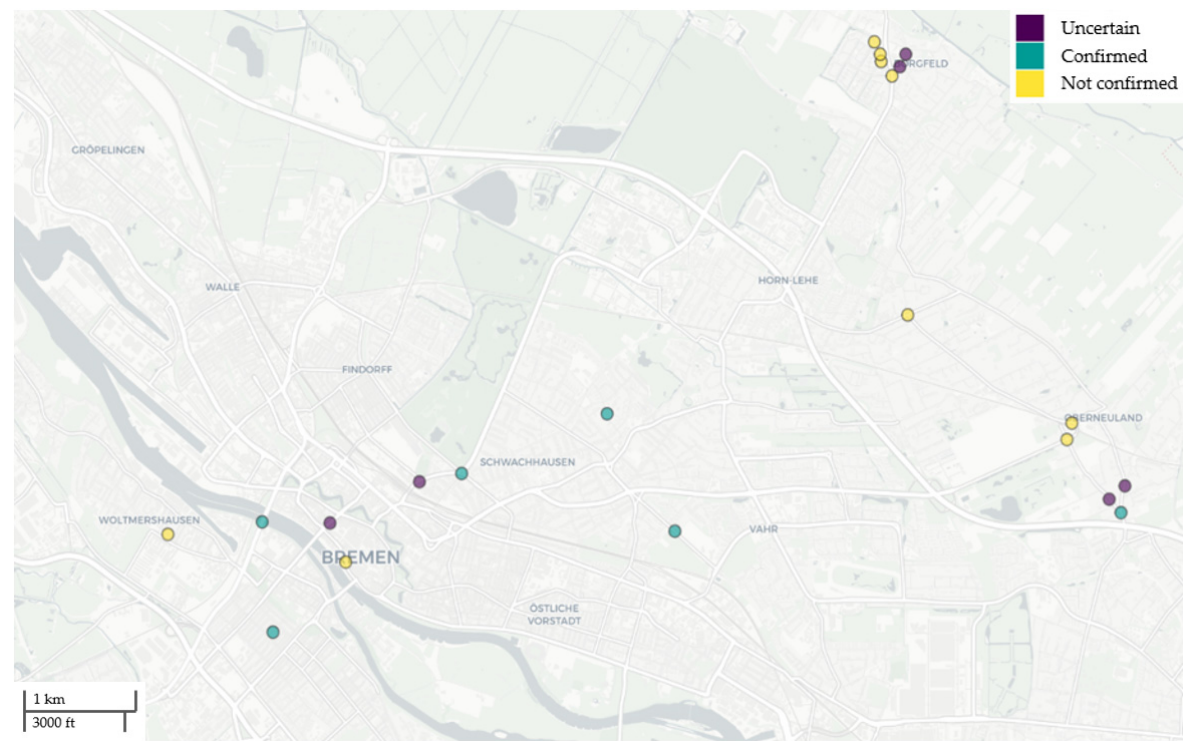
Figure A1. Map display of audited danger spots in Bremen and their respective rating. Safety 2022 , 8 , 70 Figure A2 resembles the previous map of Bremen but the different colors now indi- cate the number of collisions with property damage only per respective danger spot (see the color legend in the upper right corner of the figure). It is remarkable that for the two clusters described above, the number of registered collisions tends towards zero.